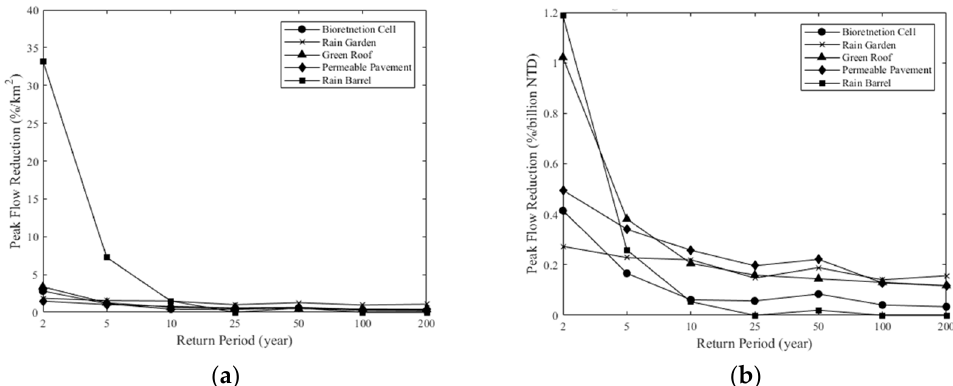
Figure 5. The HFR reduction by LIDs and detention ponds on different rainfall durations and return periods: (a) quantify of the HFR reduction; ( b ) percentage of the HFR reduction.